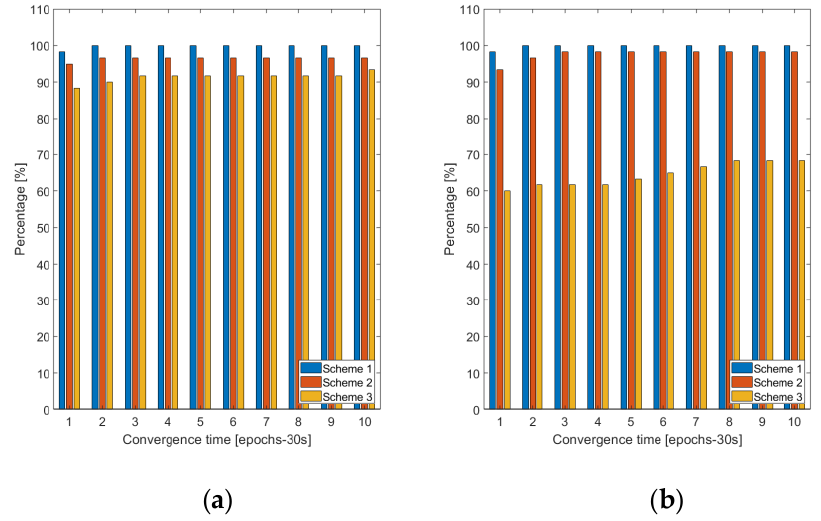
Figure 5. Cumulative histogram illustrating the convergence of the GNSS data to attain 10 cm horizontal ( a ) and vertical ( b ) for the three processing schemes.